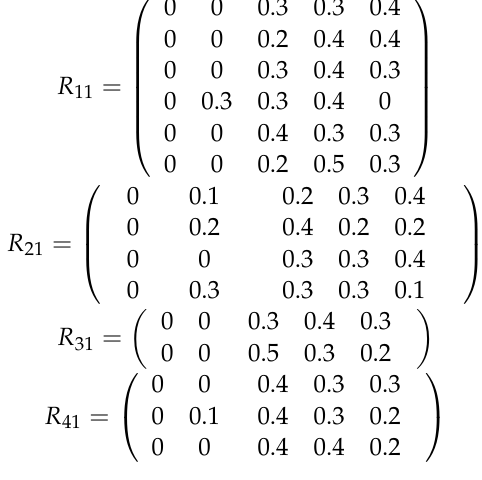
18 of 23 Figure 5. The optimal weights of risk sub-criteria related to each risk criteria. The expert panel evaluates the risk degree of each sub-criteria and the corresponding